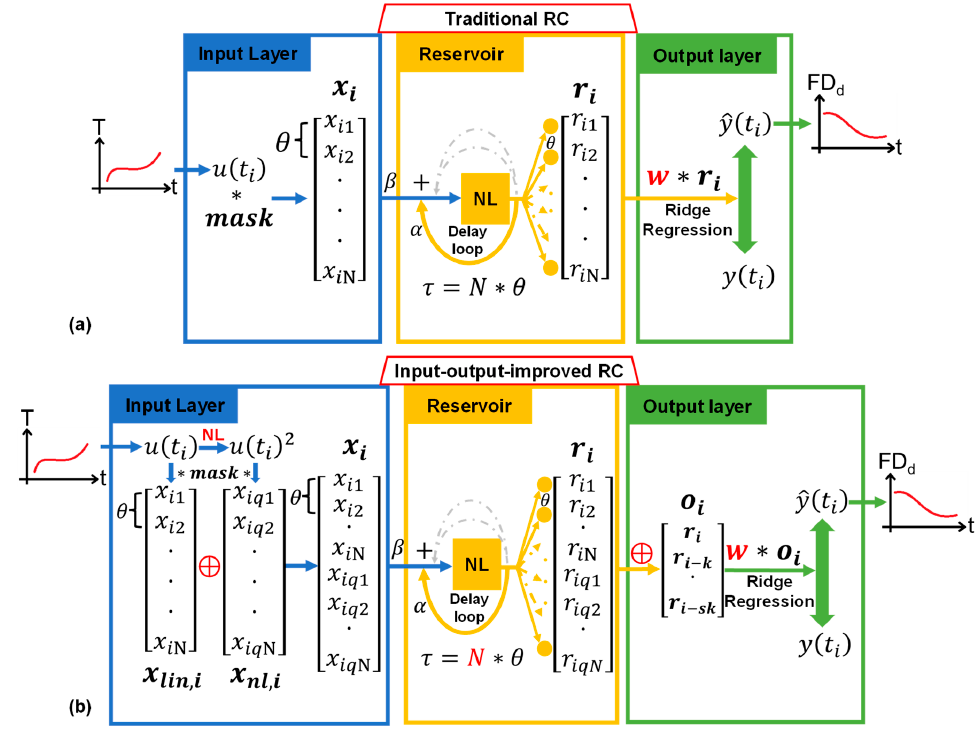
Figure 1. The T-RC and IOI-RC. ( a ) The T-RC structure: the mask signal broadcasts the original data, and the delay loop adds correlation of adjacent time data. ( b ) The IOI-RC structure: input layer increases nonlinear richness and output layer enhances long-term MC.